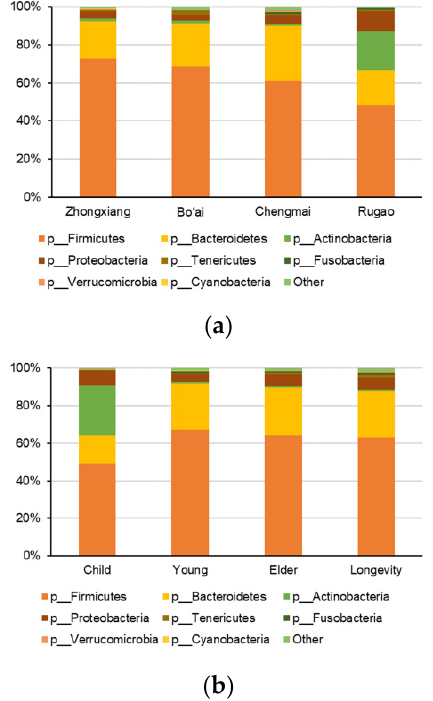
Figure 4. The composition of gut microbiota at phylum level within subjects from different regions ( a ) and across age groups ( b ).